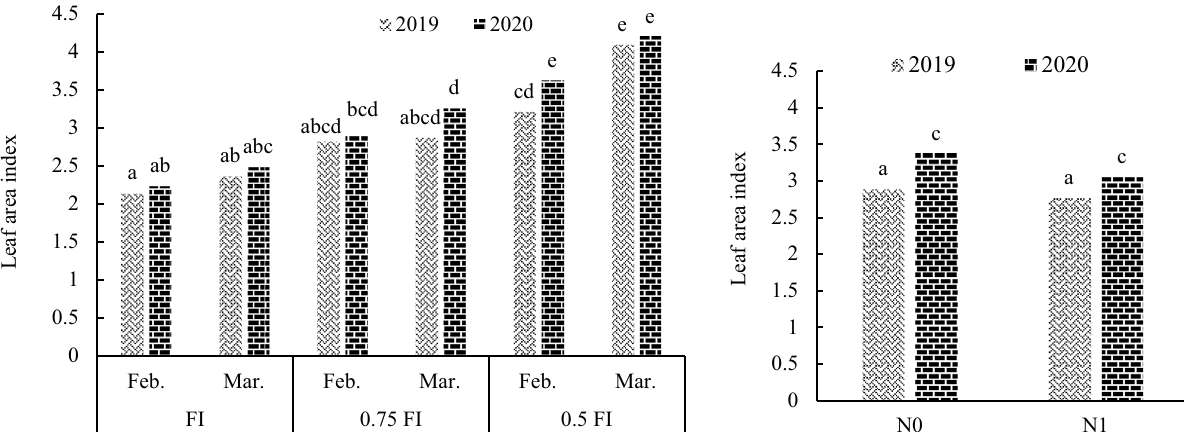
Figure 6. The interaction of irrigation × sowing date × year ( A ), and the nitrogen fertilizer main effect (averaged over irrigation and sowing treatments) on leaf area index ( B ) in 2019 and 2020 in pea. FI: full irrigation, N: nitrogen, Feb: February, Mar: March. Means with different letters did differ